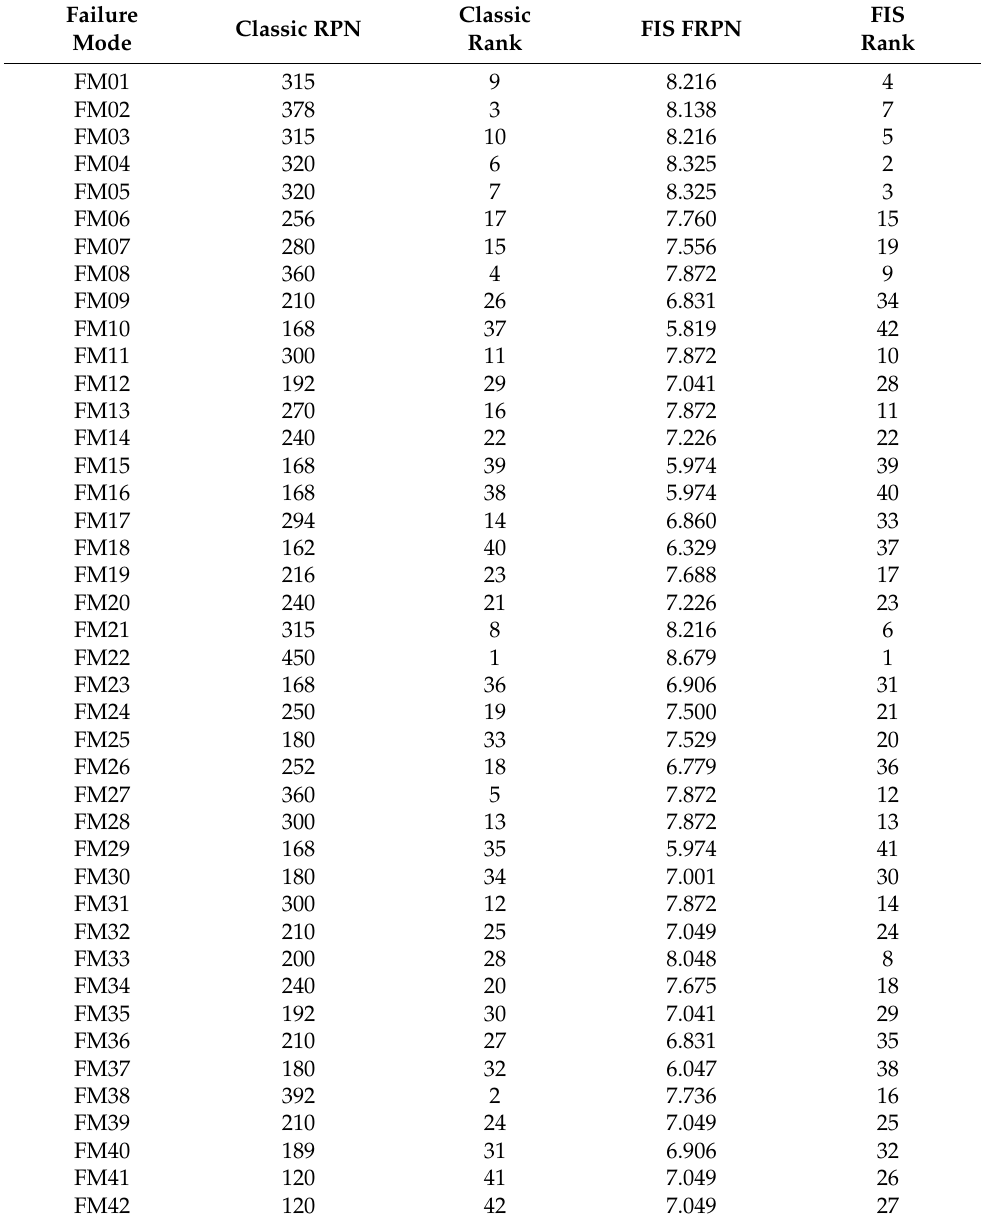
Table 10. Rankings and risk priority number for the classical and the